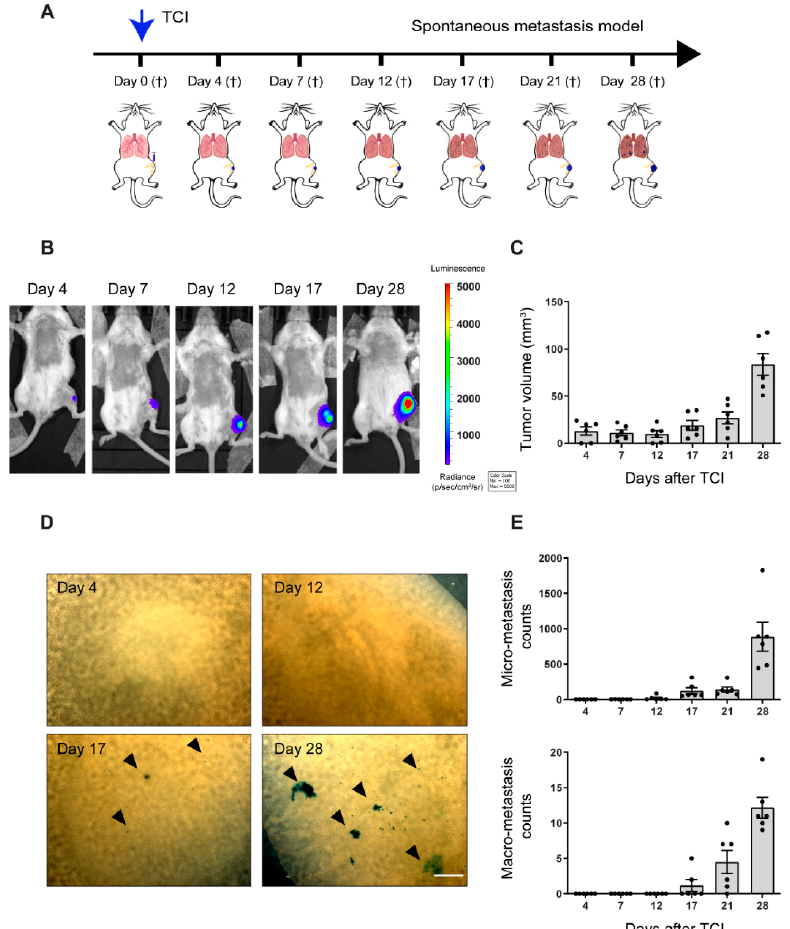
Figure 1. Characterization of spontaneous metastasis in an orthotopic 143-B osteosarcoma model. ( A ) Scheme of the experimental setup, with abbreviations: tumor cell injection (TCI); euthanasia ( † ). ( B ) Representative IVIS bioluminescence images of tumor-bearing animals sacrificed at the indicated time points. ( C ) Primary tumor growth of 143-B cells over time, monitored by caliper measurements of the tumor volume at indicated time points. ( D ) Representative images of X-gal stained metastases on lung surface of mice sacrificed at indicated time points after TCI. Scale bar, 500 µm. ( E ) Quantification of pulmonary micro-metastasis (<0.1 mm in diameter, top panel,) and macro-metastasis (>0.1 mm in diameter, bottom panel) in mice sacrificed at indicated time points. n = 6 per time point.